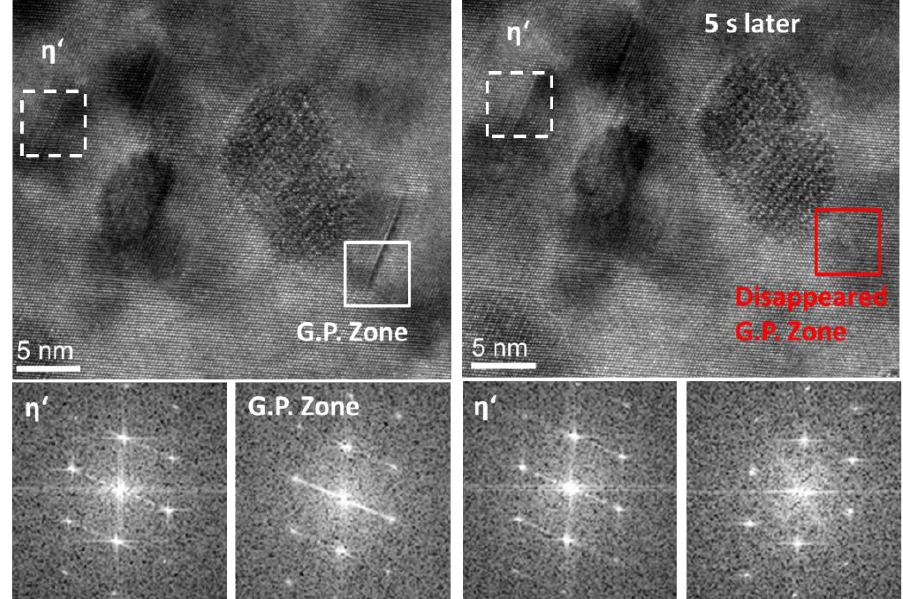
Figure 10. HR-TEM images and fast Fourier transform, FFT, diffractograms revealing unstable GP zones in the specimens after 6 h of pure ageing.